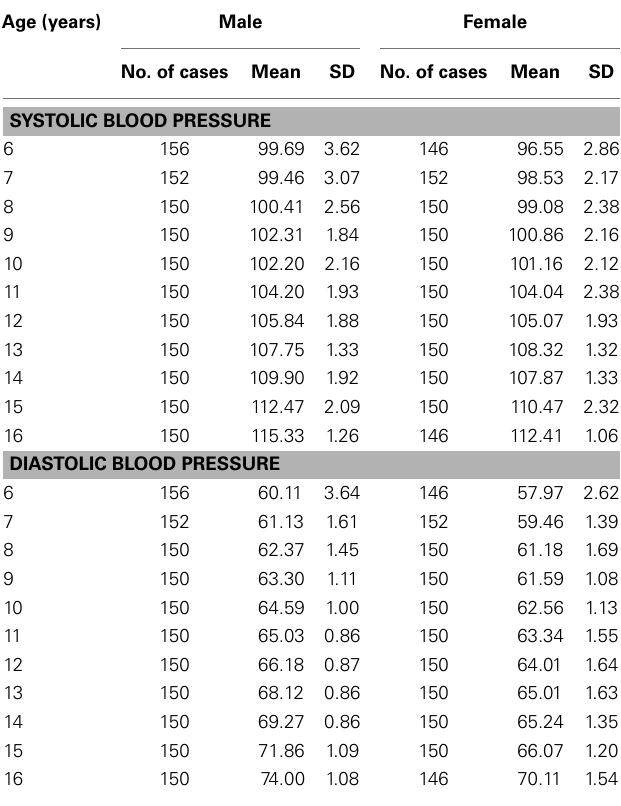
Table 1 |Table showing systolic blood pressure and diastolic blood pressure according to age and sex .